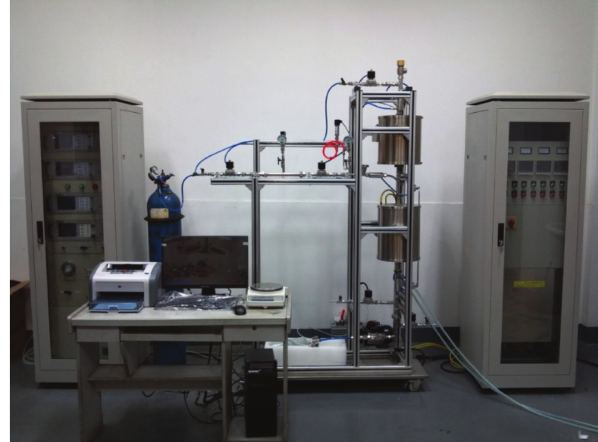
Figure 2: Appearance of the New Experimental Equipment for Combustion of Pulverized Coal in Blast